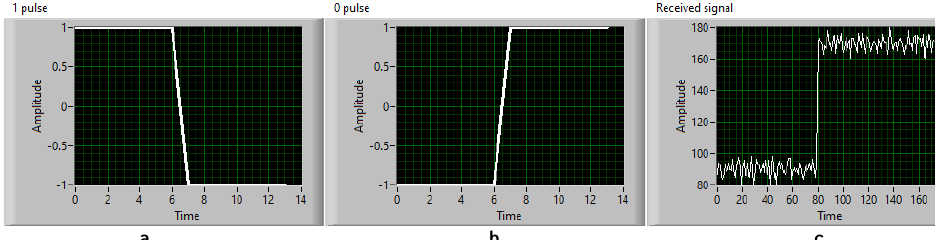
Figure 3. Manchester code patterns and the received signal from two adjacent LEDs ( a ) 1 impulse, ( b ) 0 impulse, ( c ) the received signal.